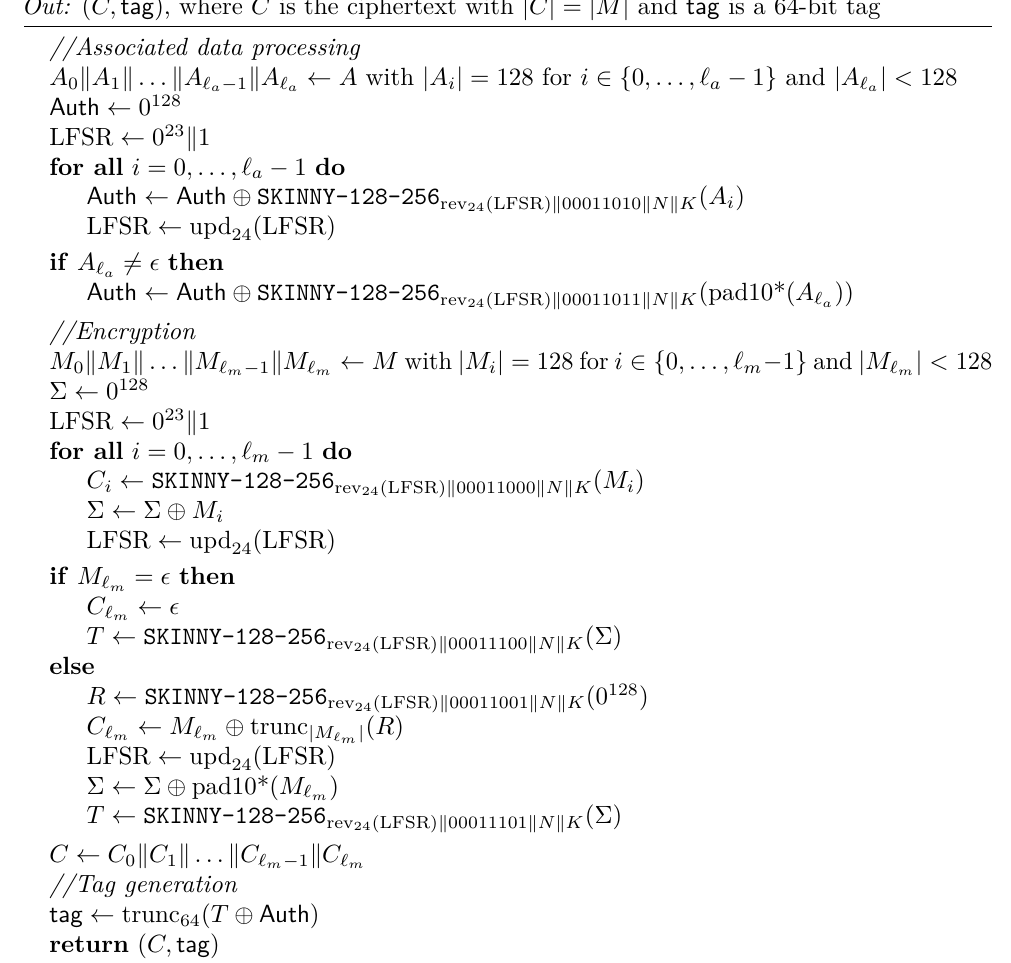
Algorithm 13 The authenticated encryption algorithm SKINNY - AEAD - M6 - Enc ( K, N, A, M ) In: 128-bit key K , 96-bit nonce N , associated data A , message M (both arbitrarily